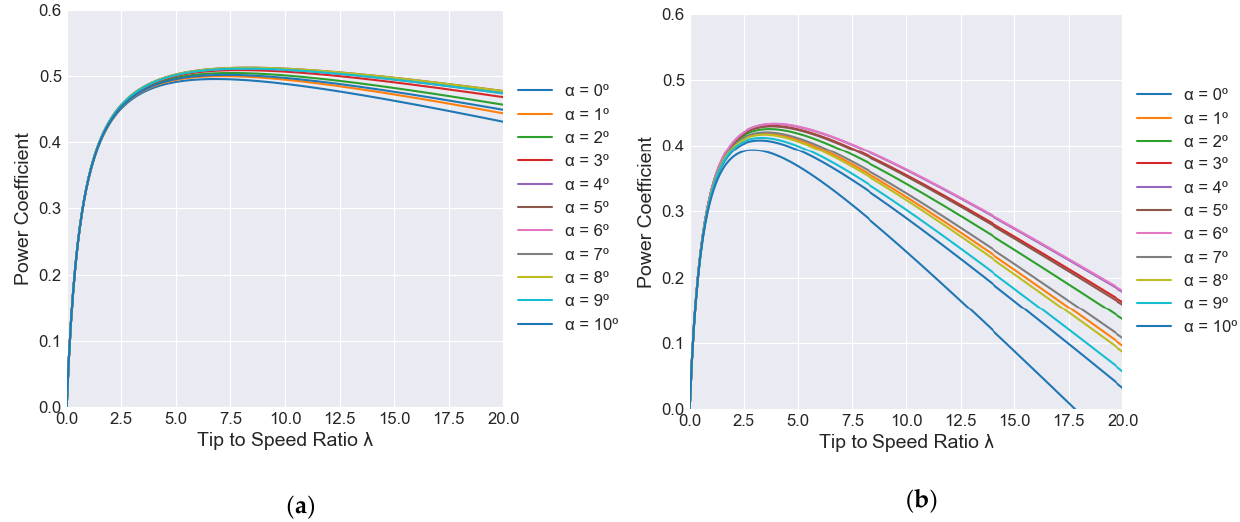
Figure 4. Effects of tip-to-speed ratio and angle of attack on turbine power coefficient for ( a ) clean turbine and ( b ) during icing based on the drag to lift data (adopted from [34]). Table 2. Results summary of the performance analysis for a wind turbine with and without icing (adopted from [34]). The results are presented for a clean turbine (Cp clean ), a turbine under icing conditions (Cp icing ), a turbine under icing conditions with pitch control (Cp α ), and a turbine under icing conditions with pitch and tip-to-speed ratio control (Cp αλ